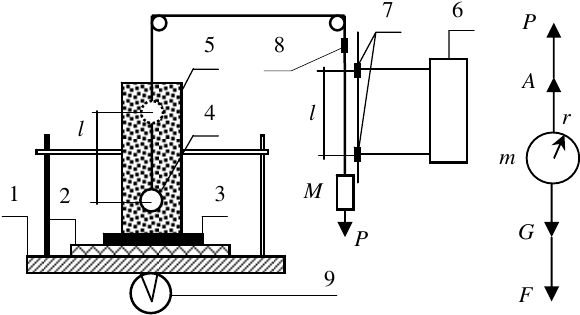
Fig 3. Installation for rheological measurements of con- crete mixtures: 1 – vibration platform, 2 – removable bot- tom of cylinder, 3 – rubber insert, 4 – lead ball, 5 – cylinder, 6 – electronic timer, 7 – hercon sensor, 8 –